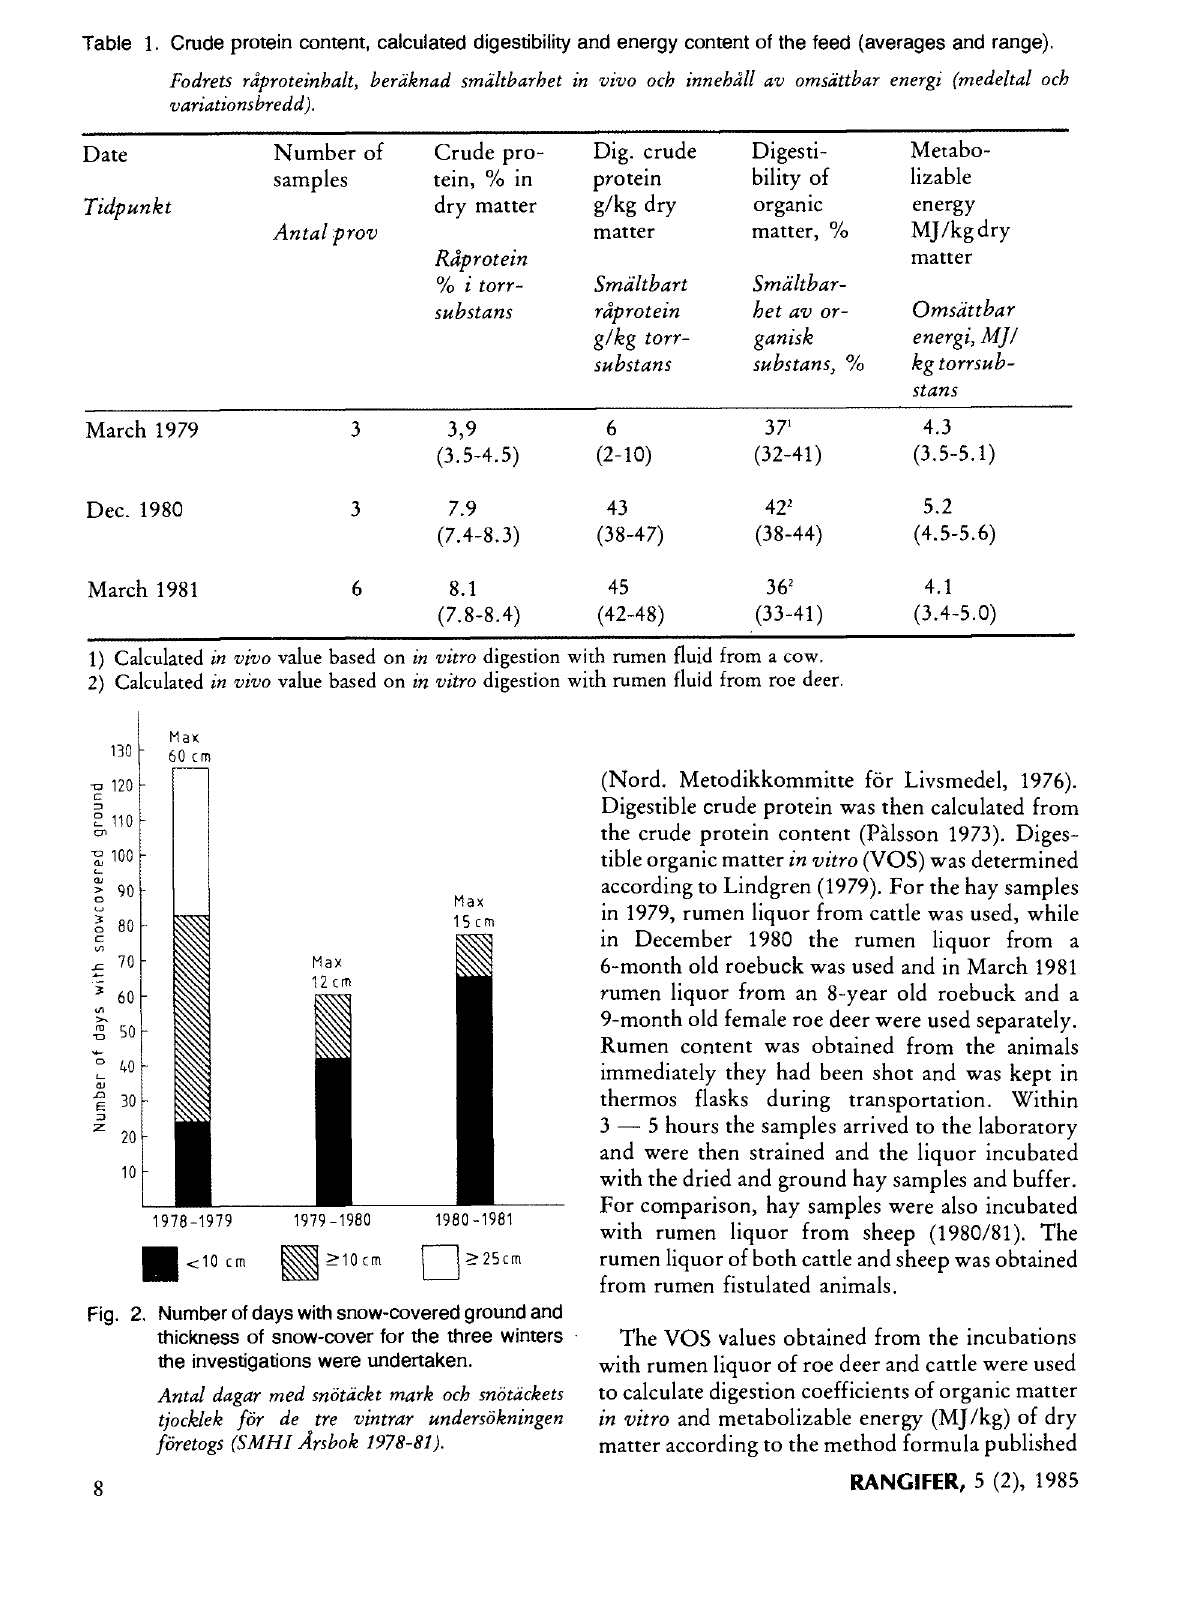
Table 1. Crude protein content, calculated digestibility and energy content of the feed (averages and range). Fodrets råproteinhalt, beråknad smaltbarhet in vivo och innehdll av omsdttbar energi (medeltal och variationsbredd).